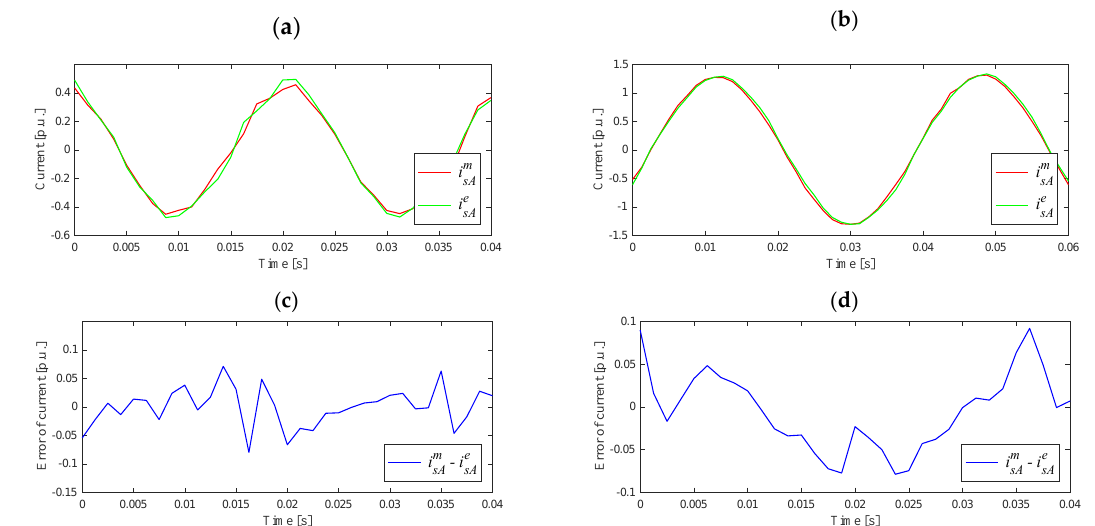
Figure 7. Measured and estimated current in phase A for the first case ( a ) and the seventh case ( b ), differences between the measured and estimated currents: ( c ) for ( a ), ( d ) for ( b ).